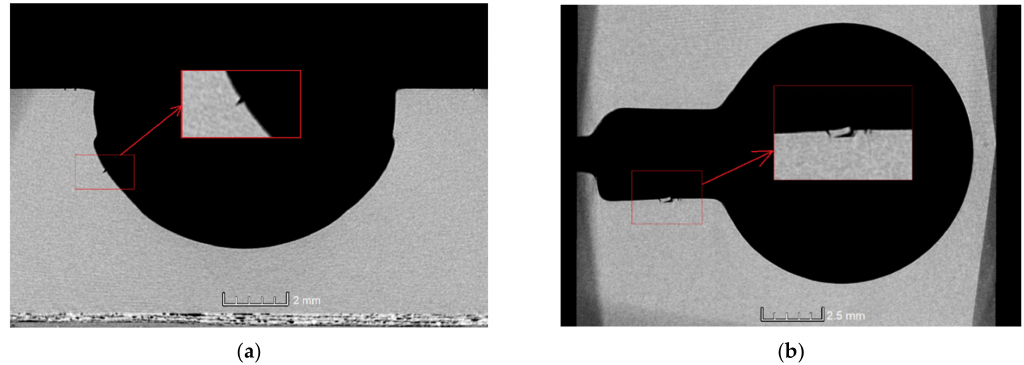
Figure 15. Two types of defects were present in the measured sample: ( a ) cracks; ( b ) flaking.